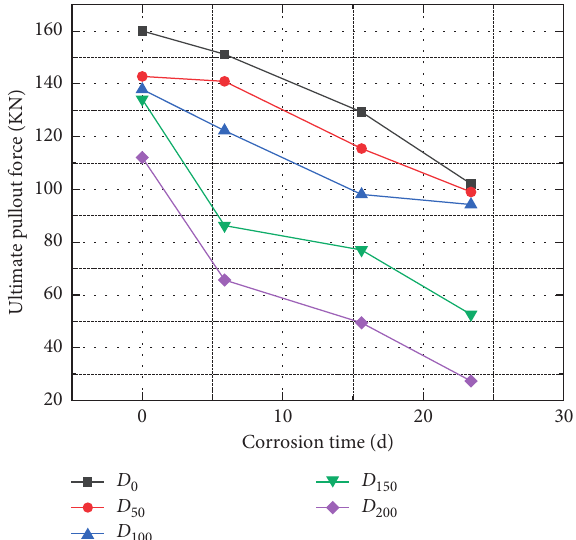
Figure 7: The change of ultimate pull-out force of steel reinforcements.